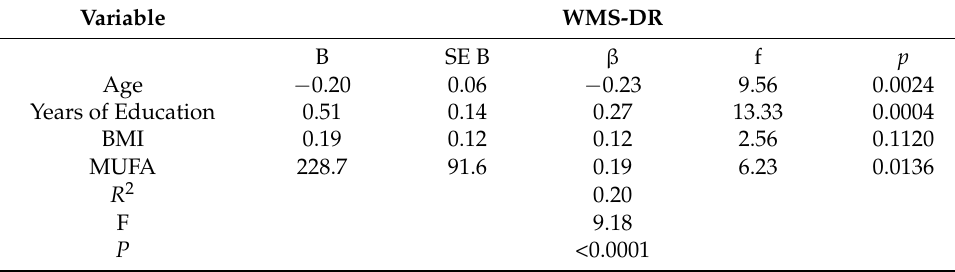
Table 6. Association between WMS-DR score and consumption of MUFA.